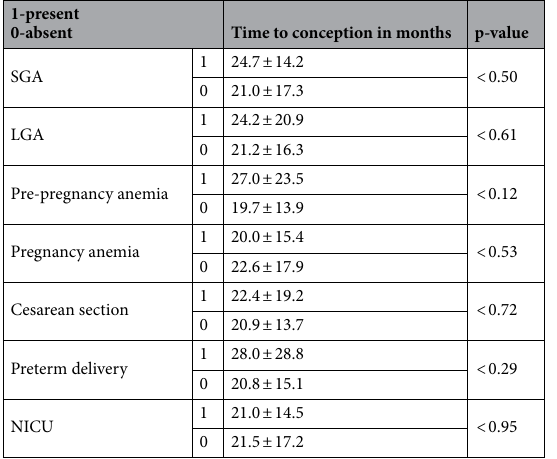
Table 3. Time-to-conception in months depending on the perinatal outcomes. SGA small for gestational age, LGA large for gestational age, NICU neonatal intensive care